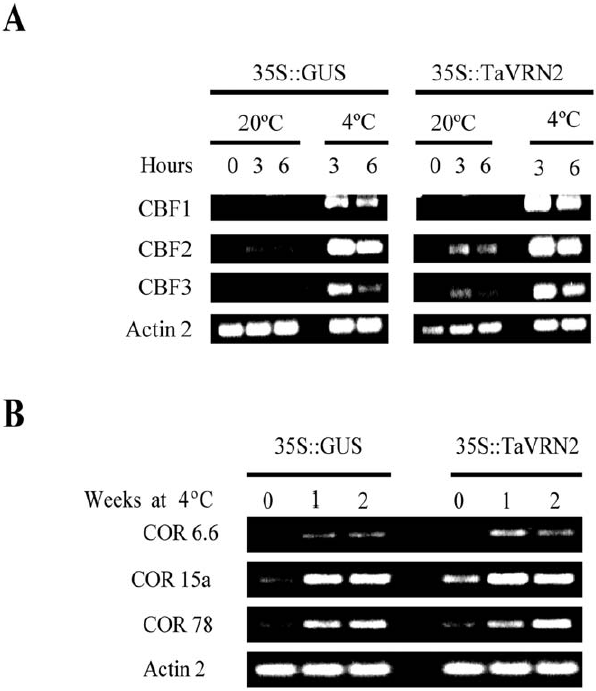
Figure 7. Effect of TaVRN-B2 over-expression on the accumula- tion of cold-regulated transcripts. A) Transcript level of CBFs genes. Control ( 35S::GUS ) and transgenic 35S:: TaVRN-B2 plants (line 1) grown under long day conditions and exposed to 4 u C for 3 and 6 hours. B) Transcript level of CORs genes. Control ( 35S::GUS ) and transgenic 35S::TaVRN-B2 plants (line 1) grown under long day conditions at 4 u C for 1 and 2 weeks. Transcripts levels were measured by RT-PCR. Each experiment was repeated three times using RNA prepared from three biological samples with similar results.